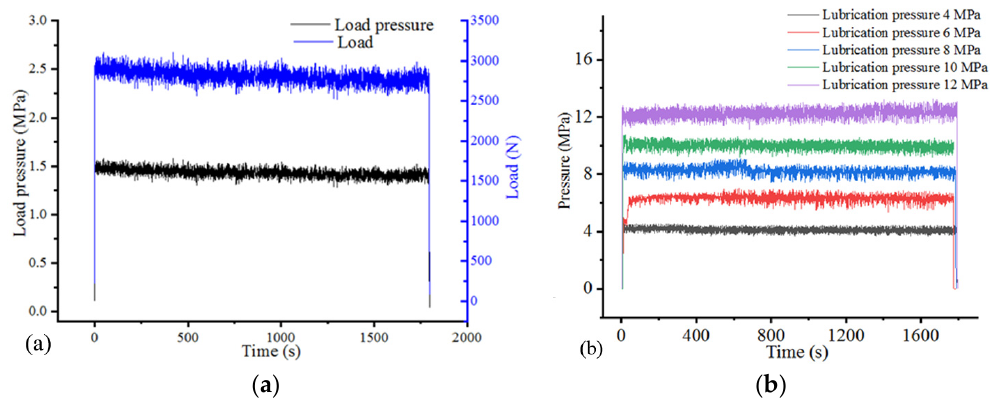
Figure 4. ( a ) The normal load on piston rod; ( b ) the lubrication pressure curves of high-water-based fluid in friction pairs.